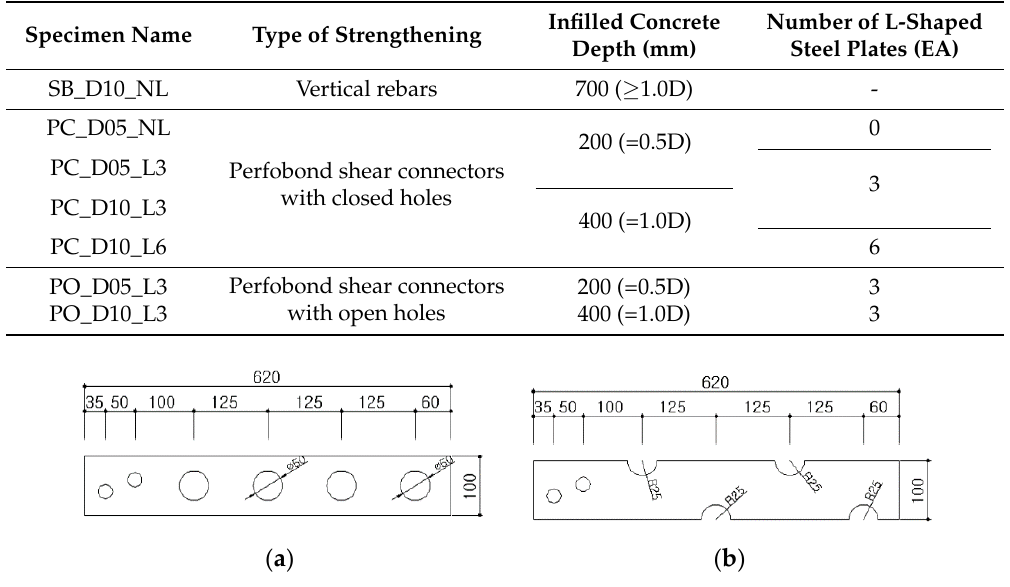
Table 1. Details of test specimens.